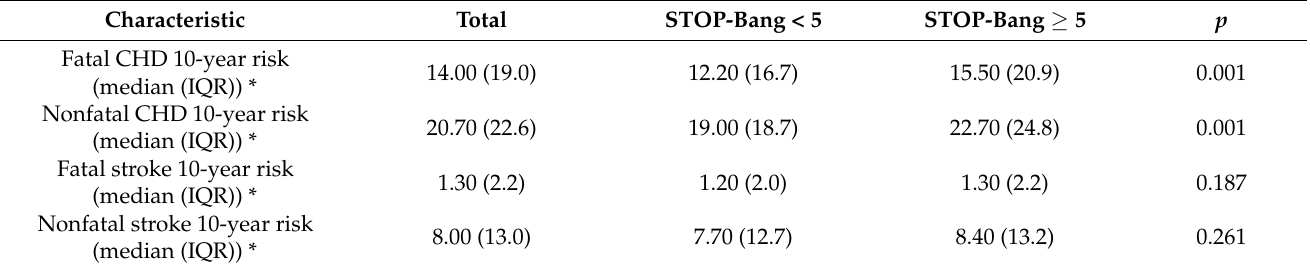
Table 1. The 10-year cardiovascular risk assessed by the UKPDS risk engine stratified by STOP- Bang score.